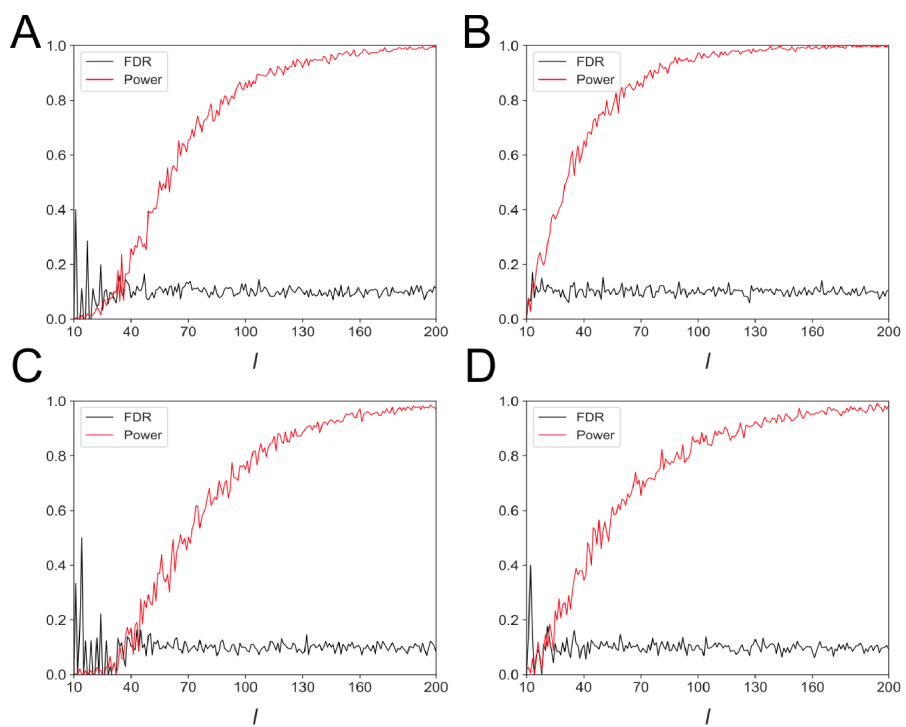
Fig 2. Simulation experiments on DC combined with the BH method in terms of Power and FDR (the target level is 20%). (A) Each pair of vectors are dense, and k dimensions are shared with a linear transform. (B) Each pair of vectors are sparse with 90% zero entries and k dimensions are shared with a linear transform. (C) Each pair of vectors are dense and k dimensions are shared with a non-linear transform. (D) Each pair of vectors are sparse with 90% zero entries and k dimensions are shared with a non-linear